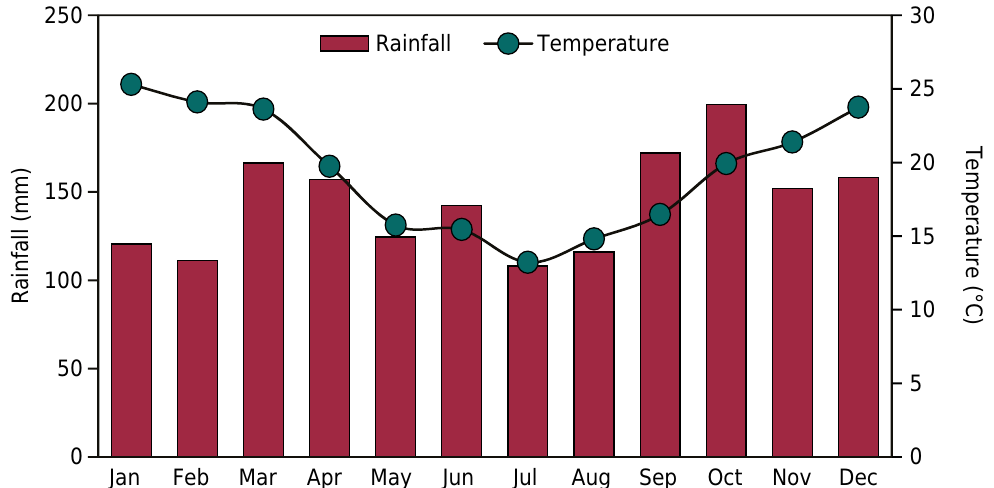
Figure 1. Monthly average temperature and rainfall in Santa Maria, Rio Grande do Sul, Southern